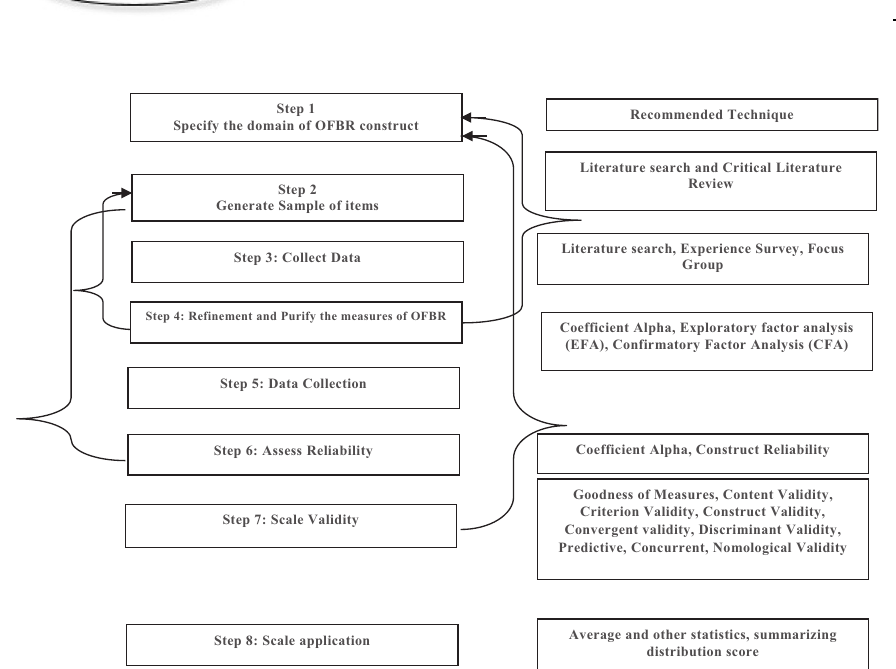
Figure 1. OFBR formative